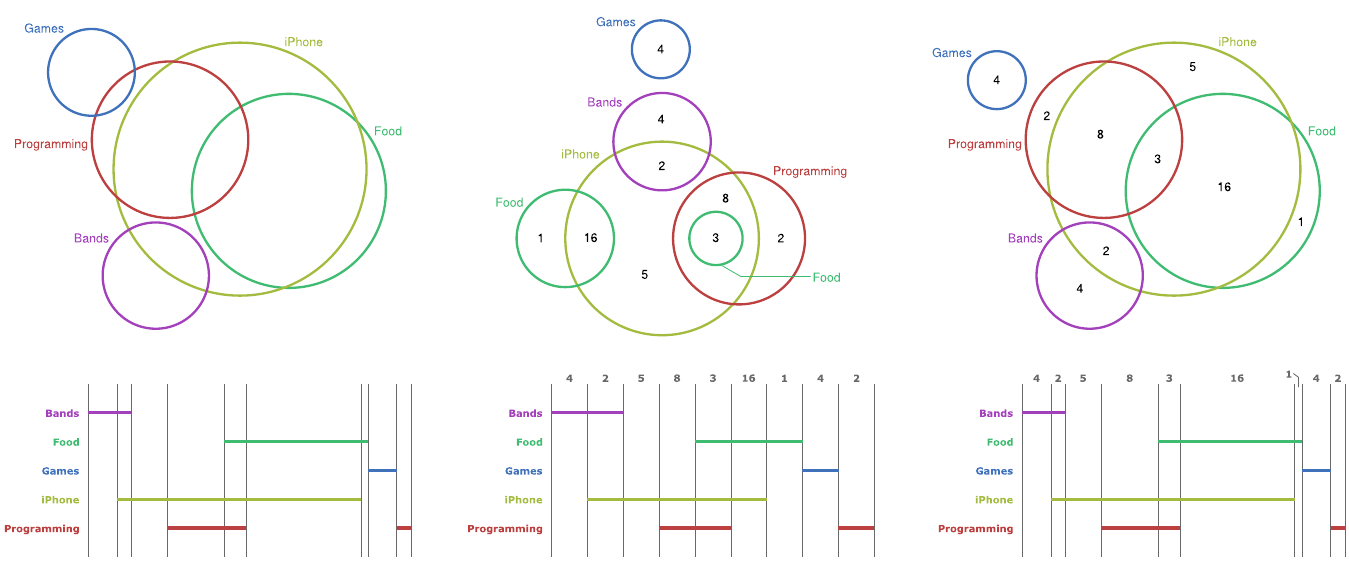
Fig 1. Representing cardinalities using proportions (left), numerical annotations (middle), and both (right); top : Euler, bottom: Linear.